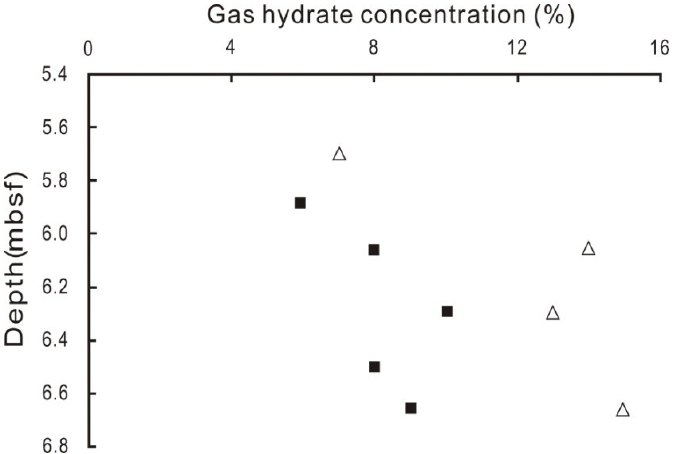
Figure 5. The estimated gas hydrate concentrations below 5.7 mbsf. Solid squares and open triangles represent the results derived from Cl − concentrations and δ 18 O values,